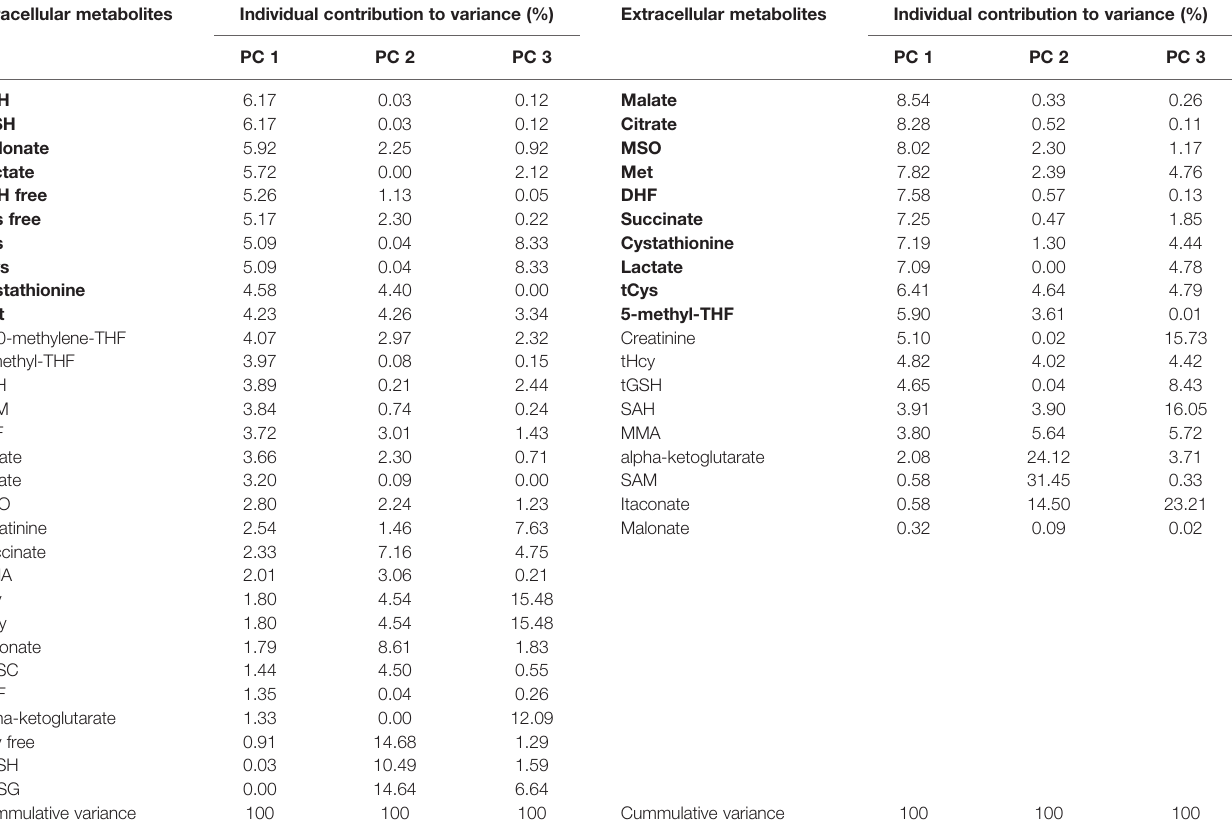
TABLE 2 | Individual contribution of metabolites to variance in principal component analysis. Intracellular metabolites Individual contribution to variance (%) Extracellular